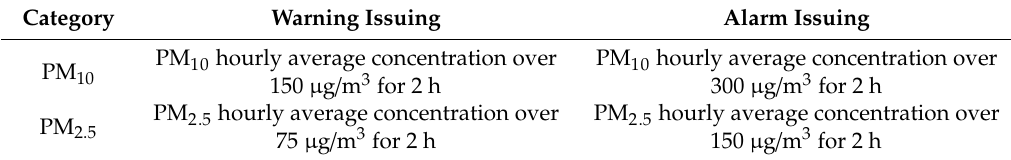
Table 3. Particulate matter warning and alarm issuing grade